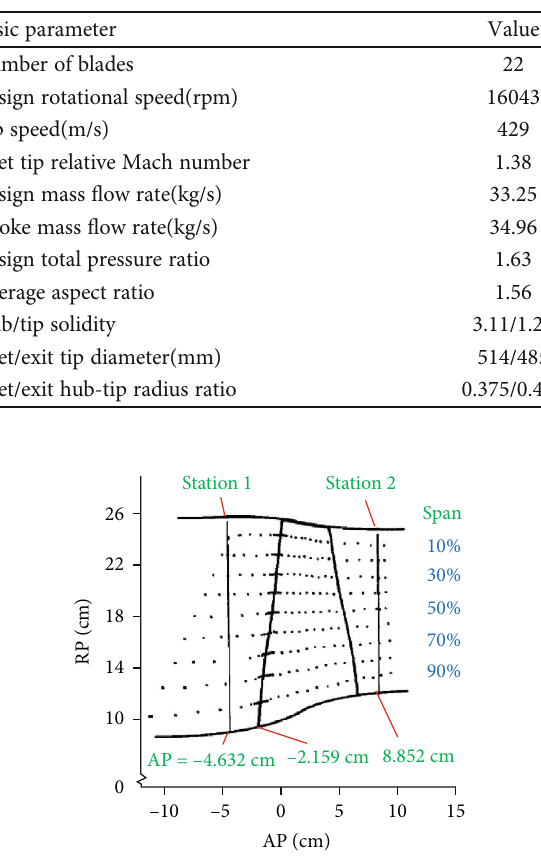
Figure 1: Meridional view of laser anemometer and aerodynamic survey locations for Rotor 67